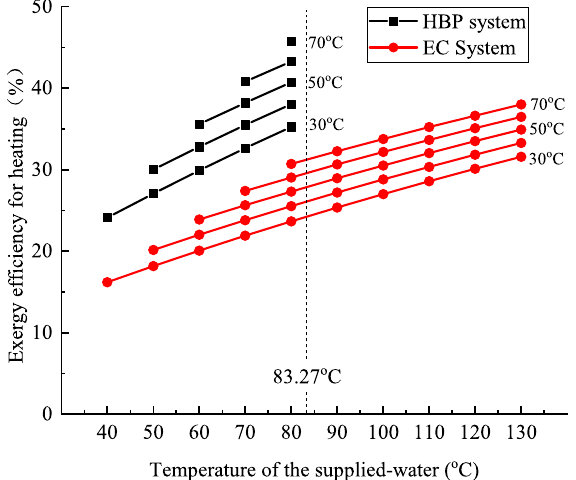
Figure 12. Influences of the returned- and supplied-water temperatures on η ex